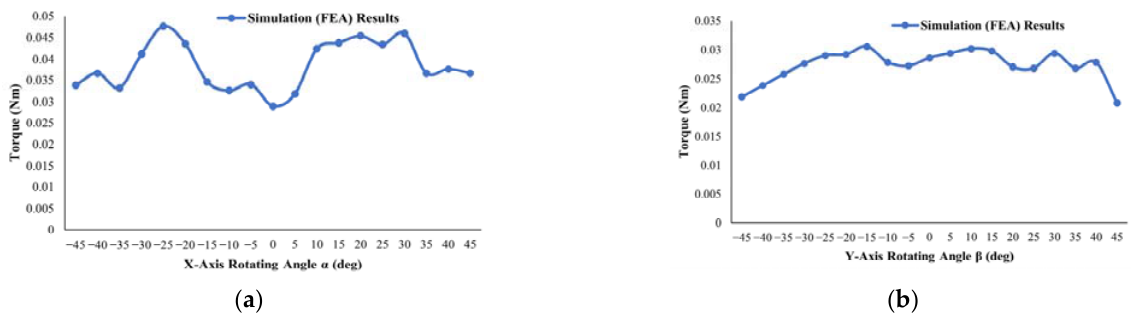
Figure 12. Torque values of the motor in the loaded condition rotating around the X ‐ axis from α = 0° to α = ±45° ( a ) and rotating around the Y ‐ axis from β = 0° to β = ±45° ( b ).